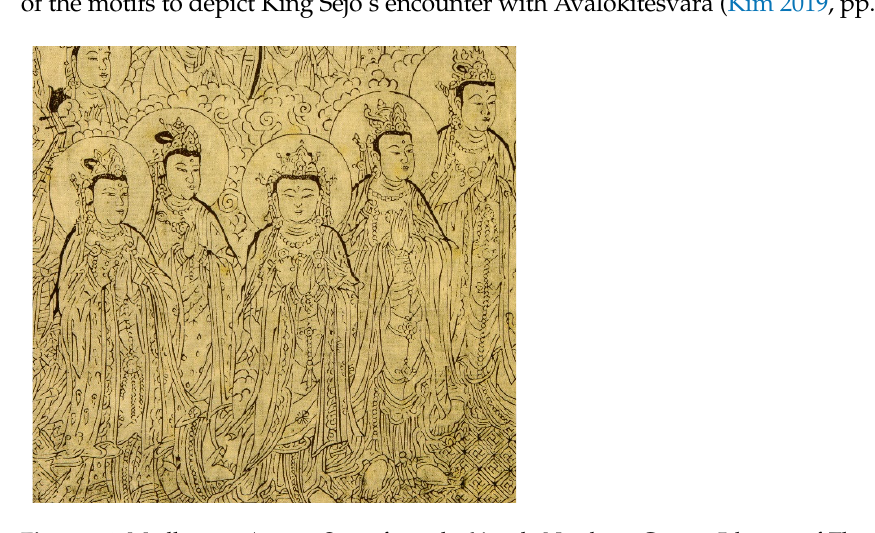
Figure 14. Madhyama Agama Sutra from the Yongle Northern Canon, 5th year of Zhengtong (1440), 38.0 × 13.0 cm, Zhihuasi 智化寺 Temple, Beijing (Arranged by the author) Beijing Cultural Exchange Museum (2007).